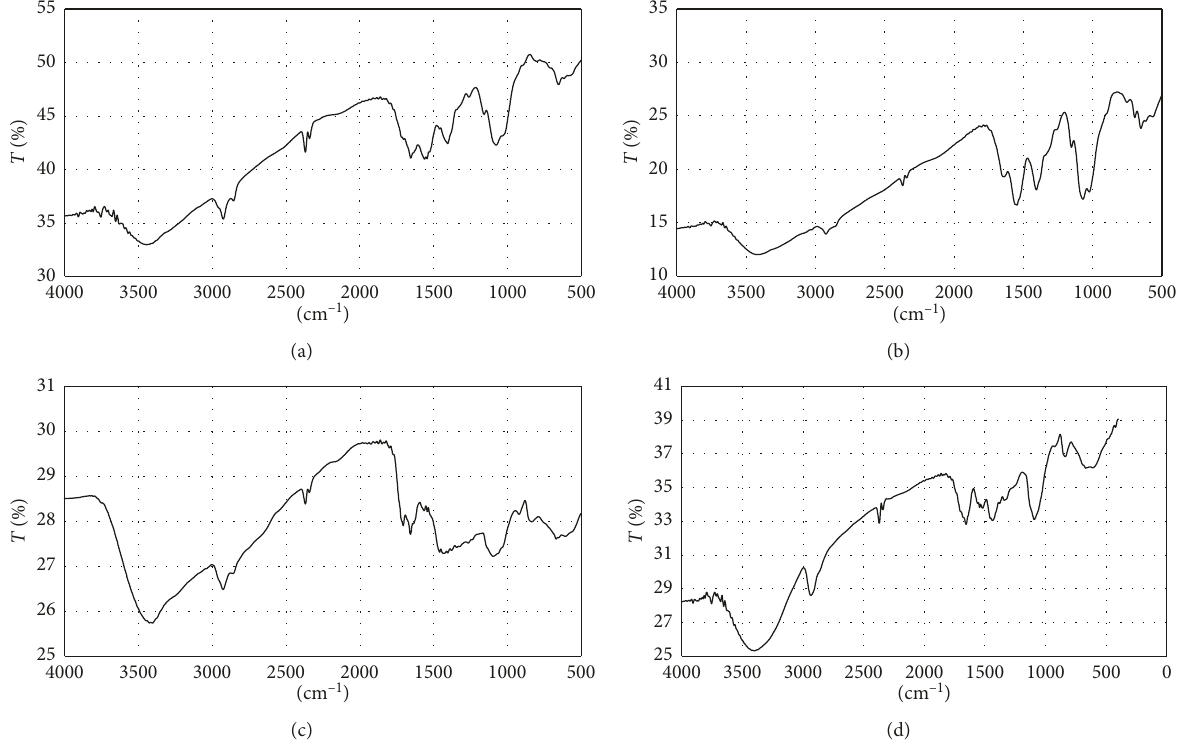
Figure 3: FT-IR spectra of chitosan, PVA, and the prepared films. (a) Chit, (b) Chit/C, (c) PVA, and (d) Table 1: Spectral data of chitosan, PVA, and the prepared nanocomposite films. Chitosan Chit/C